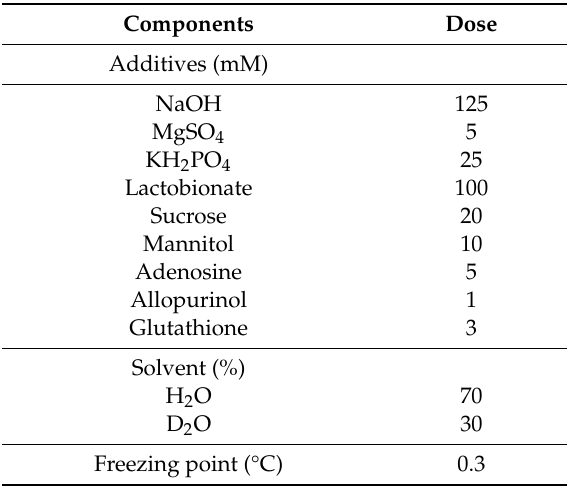
Table 1. Components of